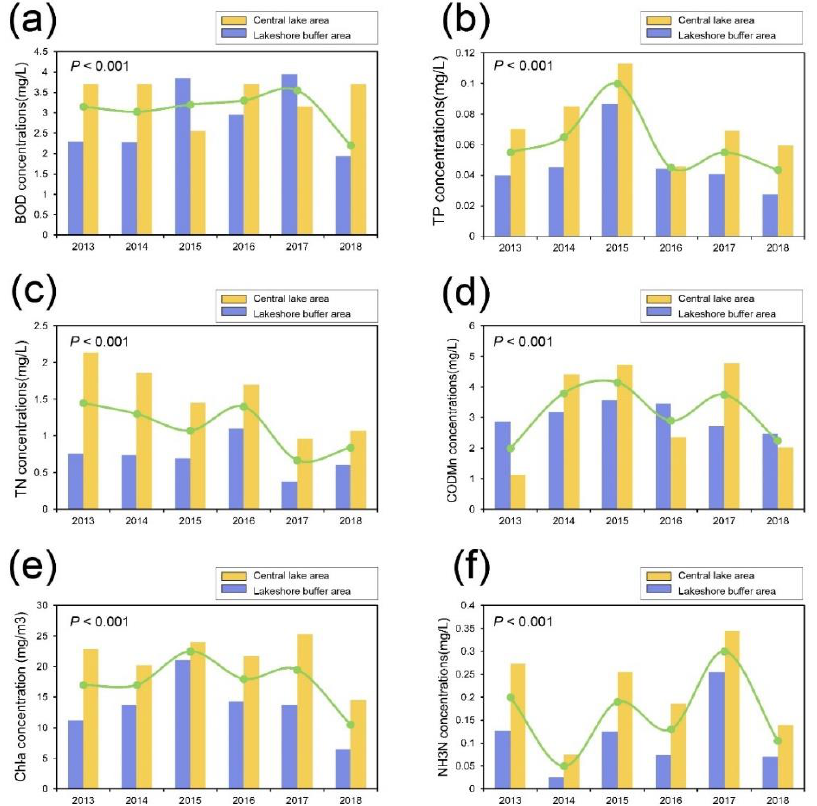
Figure 8. Annual average concentrations for the model-retrieved water quality variables for ( a – e ): ( a ) BOD, ( b ) TP, ( c ) TN, ( d ) CODMn, ( e ) Chl and ( f ) NH3-N (the units are consistent with those given earlier). The purple bars represent water quality in the central lake areas, while the yellow ones represent the lakeshore area. The green lines represent the average concentration of water quality components for each year.